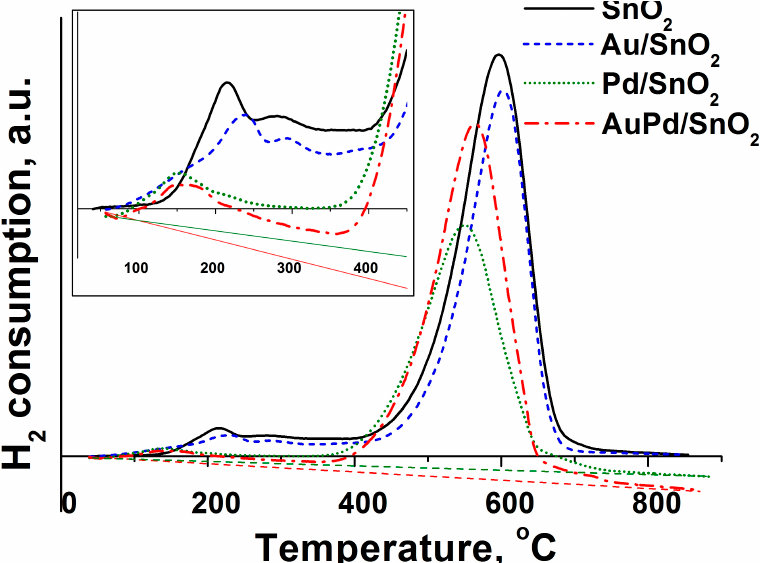
Figure 3. Spectra of H 2 consumption during thermo-programmed reduction by hydrogen of synthesized materials. Spectra are not normalized to the mass or total surface area of samples due to the excessive hydrogen absorption by metallic Pd particles.